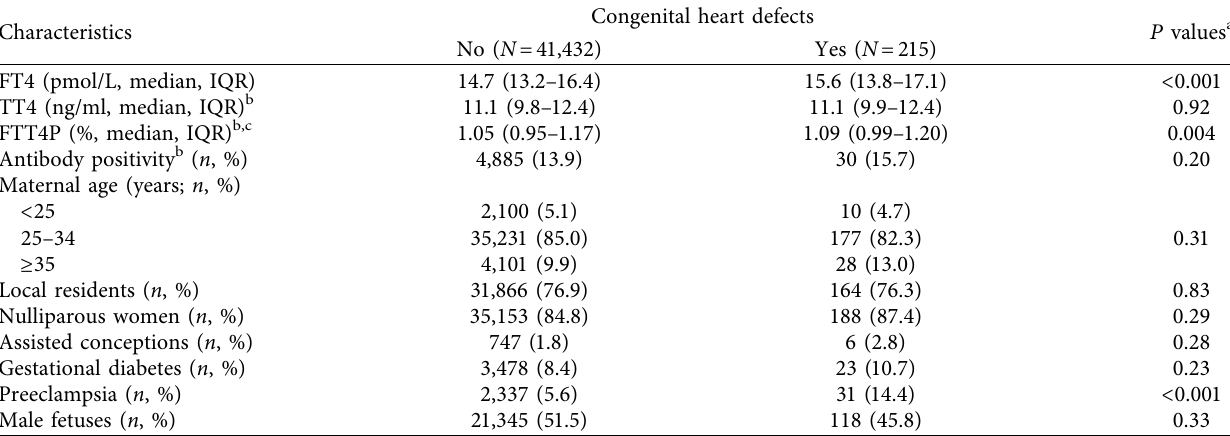
Table 1: Basic characteristics of the